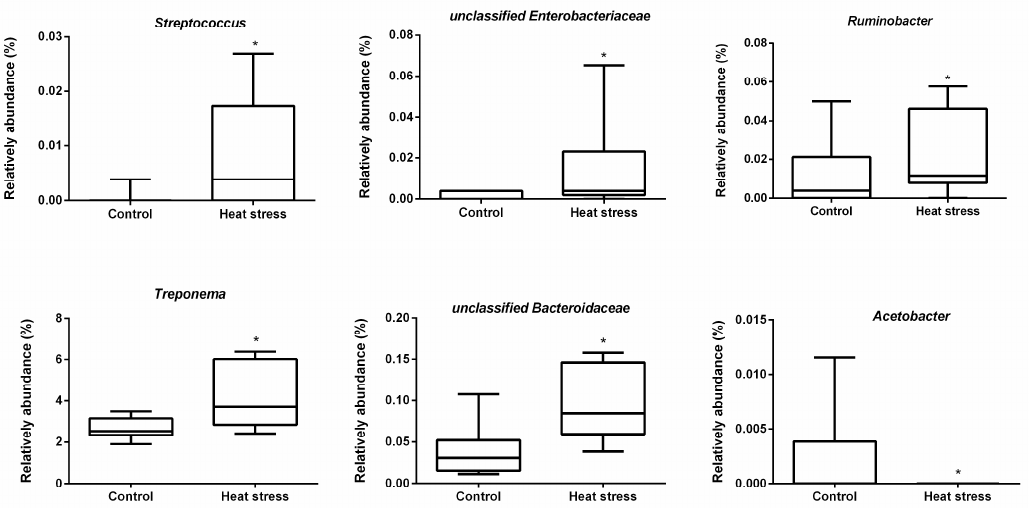
Figure 5. The linear discriminant analysis effect size ( LEfSe) of the changes in the rumen bacterial community by heat stress. ( A ) Visualization of differential bacteria with the effect sizes. The length of the bar represents a log10 transformed effect size (LDA) score. The colors represent the group in which that taxa were found to be more abundant compared to the other group. ( B ) Cladogram of differential bacteria. The color represents the branch of the phylogenetic tree that most significantly represents a certain group.